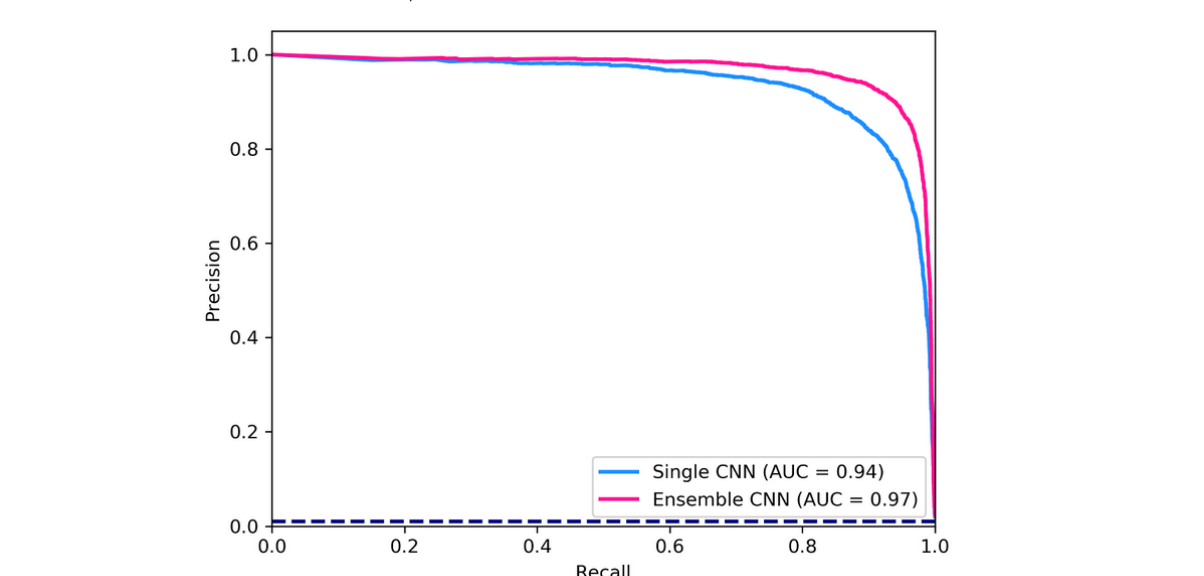
Figure 3. Precision-recall curves with the corresponding area-under-the-curve values, for the single and ensemble convolutional neural network models for the recognition of coughing. The dashed line represents the curve for a random classifier showing the proportion of cough-class instances to the total amount of instances. AUC: area under the curve; CNN: convolutional neural network.